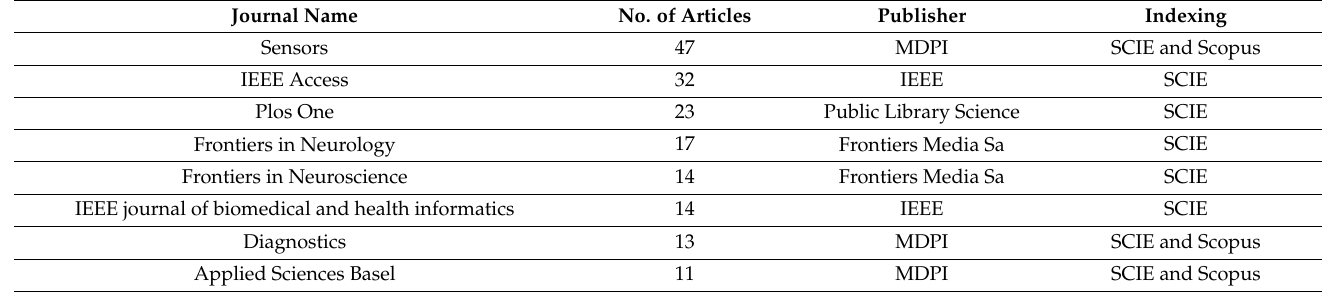
Table 1. Major influential journals publishing on diagnosis of PD (2015–2022) from Web of Science database.